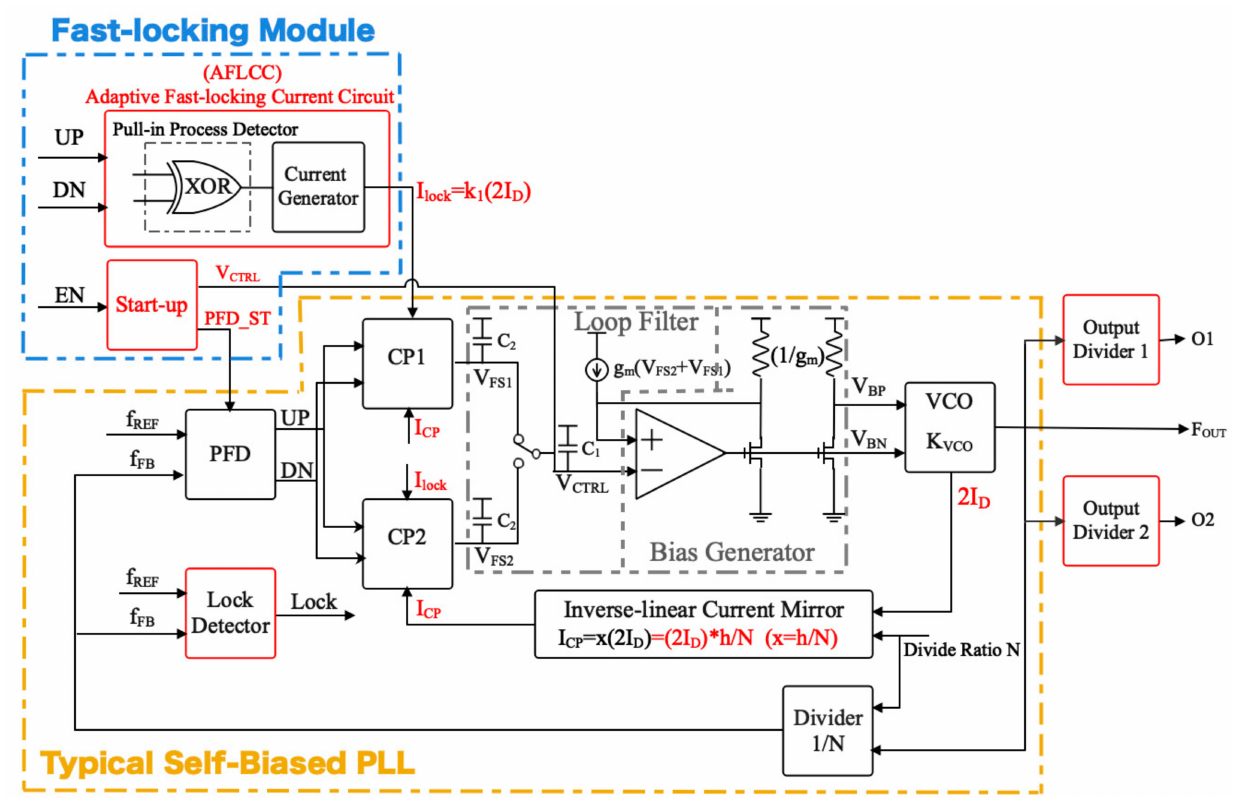
Figure 1. The proposed AFL-SPLL block